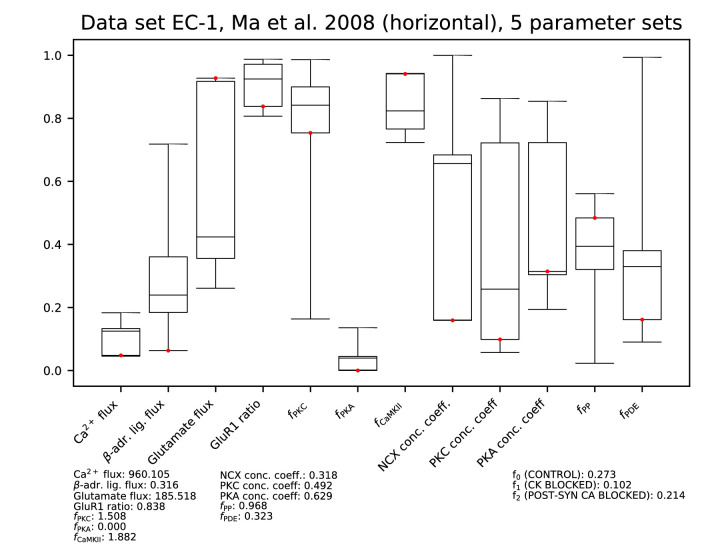
Parameters for data set EC-1.Ranges of each parameter among the accepted parameter sets from the fitting of Figure 9. All parameters are linearly scaled between 0 and 1, which represent the minimal and maximal value of the corresponding model parameter. The values of the parameters reproducing the data of Figure 9A and C are presented by red dots, and their exact (non-scaled) values are listed below the figure. The values of the error functions corresponding to the listed parameter set are displayed in the right-most column for each experiment.